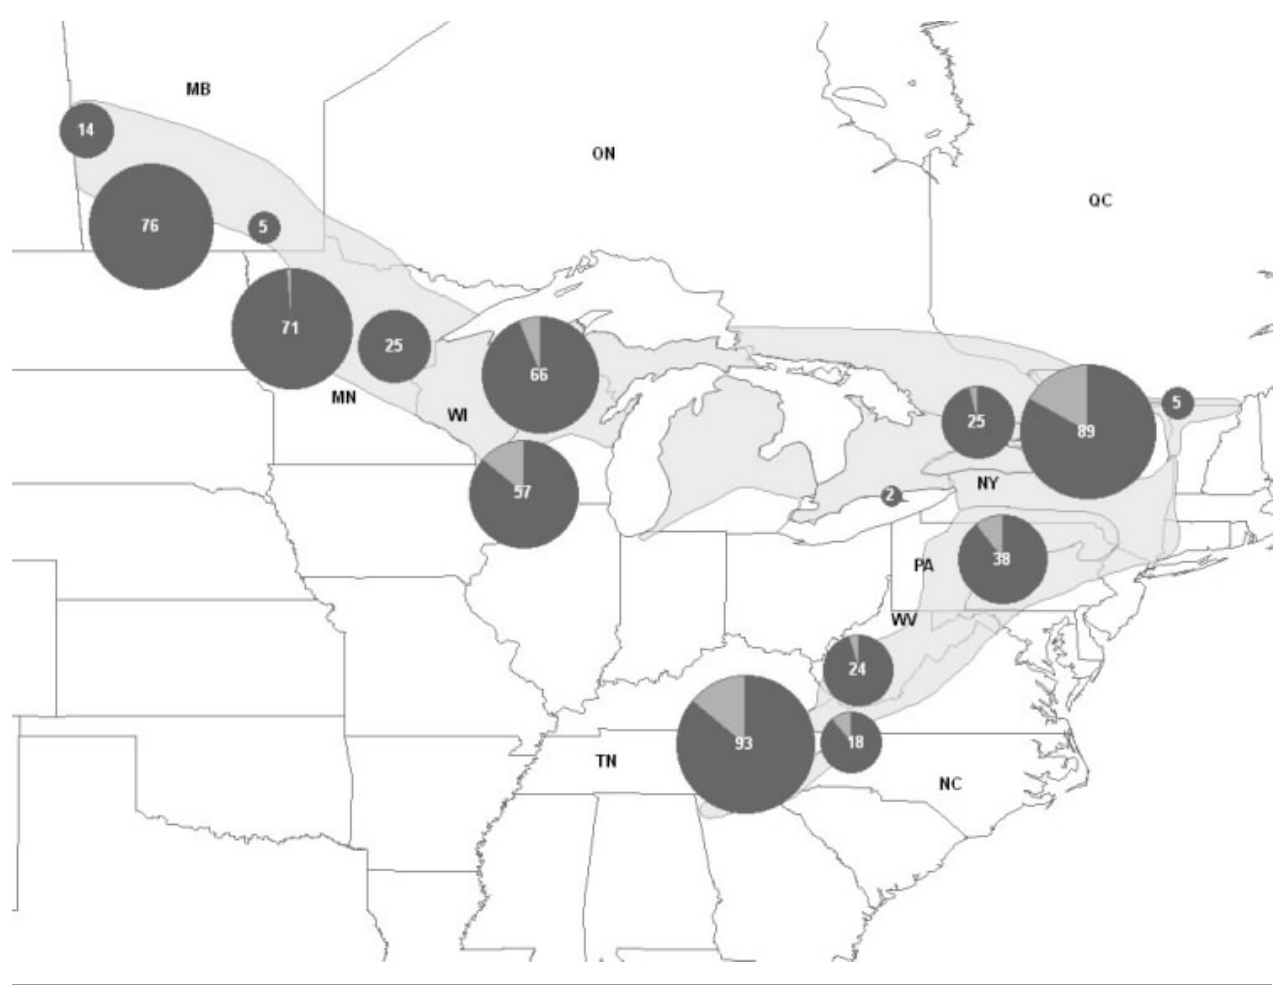
Fig. 1 . A map of northeastern North America indicating the Golden-winged Warbler breeding range (shaded area). The dark sections of the pie charts in each state/province indicate the proportion of Golden-winged Warbler samples that were assigned to the ancestral Golden-winged Warbler haplotype group; the lighter grey areas represent the proportion of Golden-winged Warbler samples assigned to the Blue-winged Warbler haplotype group. Numbers within pie charts represent the number of Golden- winged Warblers that were sampled per state/province. MB stands for Manitoba; ON, Ontario; QC, Quebec; MN, Minnesota; WI, Wisconsin; NY, New York; PA, Pennsylvania; WV, West Virginia; TN, Tennessee; and NC, North